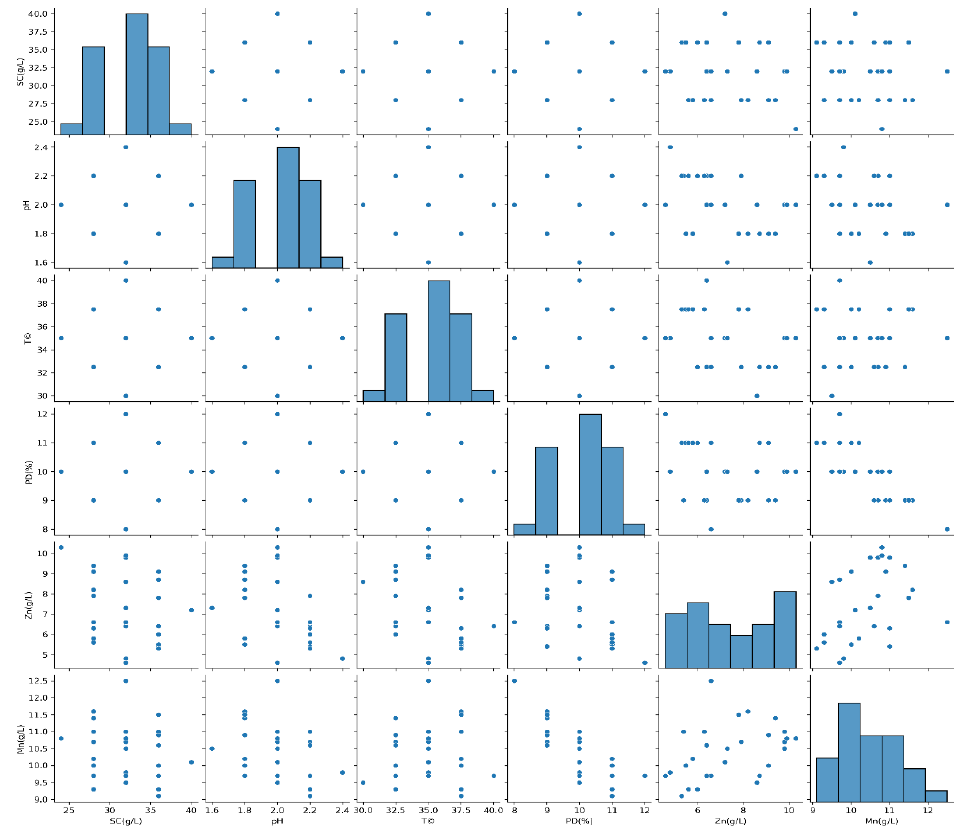
Figure 1. Pair plots for the input parameters and observed responses.